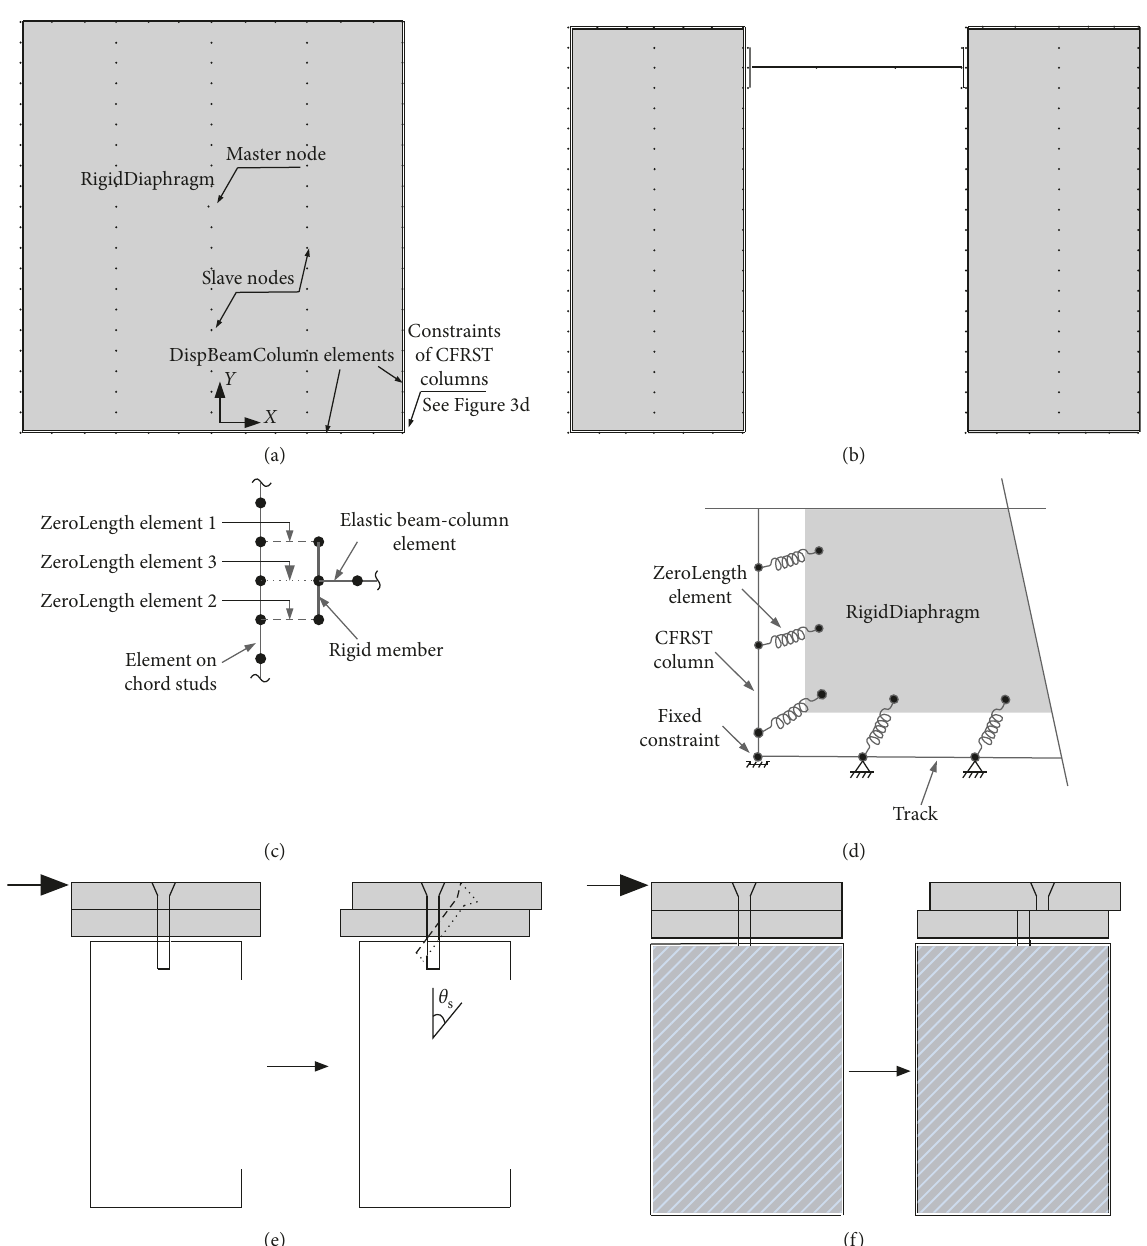
Figure 2: Numerical models of RCFS shear walls. (a) Equivalent of double-layer sheathings. (b) Equivalent method of an opening. (c) Boundary treatments of an opening [17]. (d) Boundary constraints. (e) Failure mode 1 of sheathing-to-stud connections with double- layer wallboards. (f) Failure mode 2 of sheathing-to-stud connections with double-layer